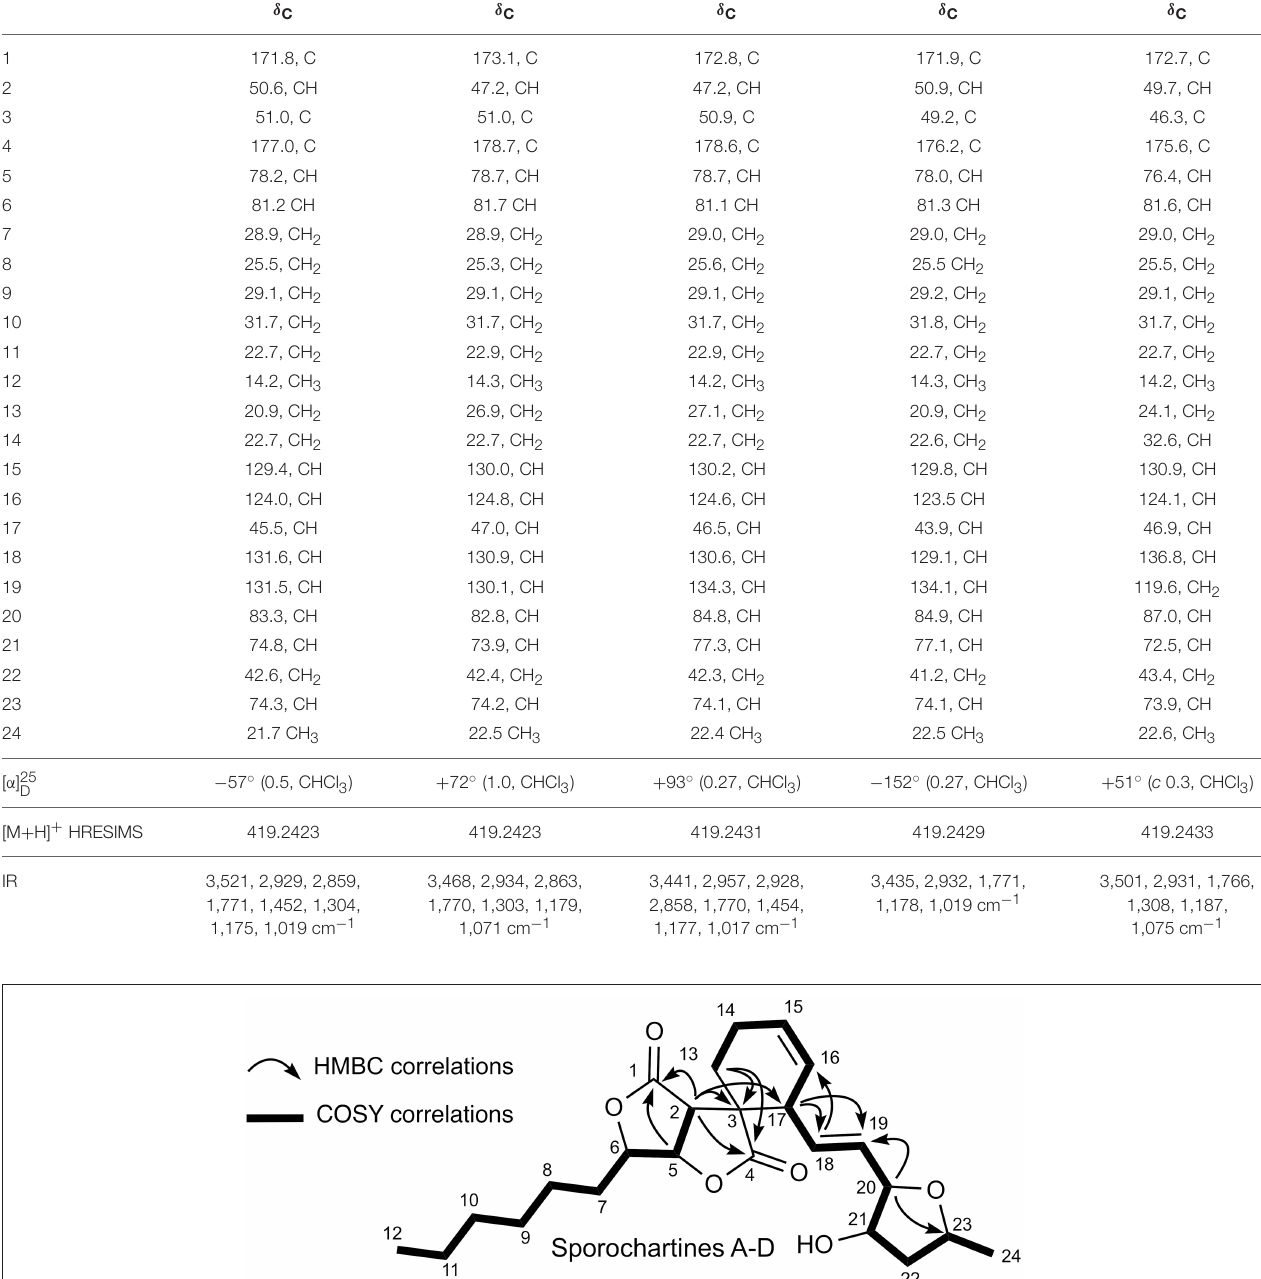
FIGURE 3 | COSY and HMBC key connectivities for sporochartines A–D.